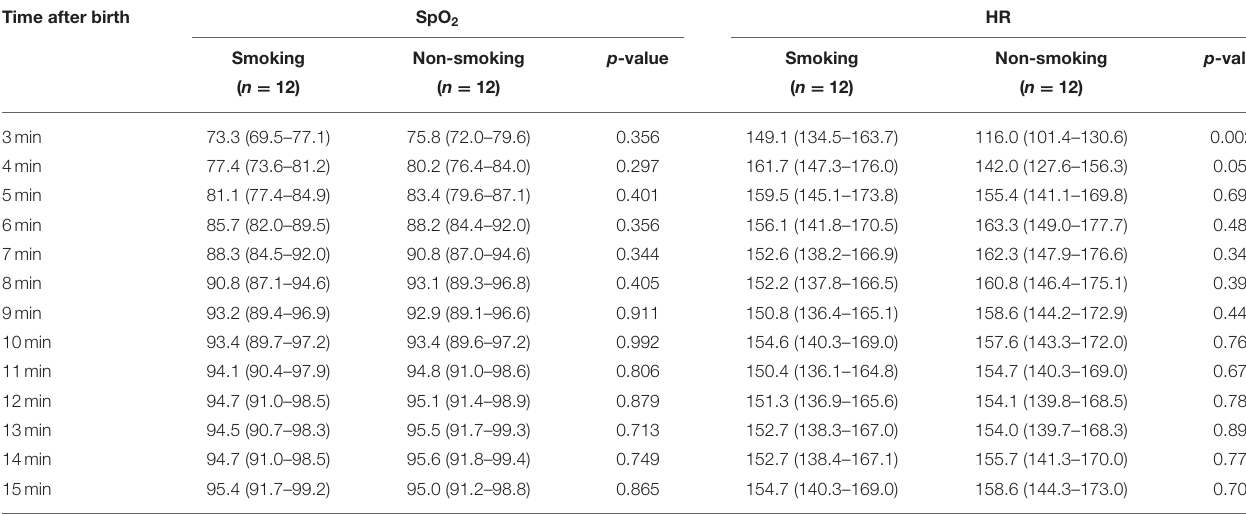
TABLE 3 | Arterial oxygen saturation (%) and heart rate (bpm) in term neonates from mothers who had smoked during pregnancy compared to term neonates from mothers who had not smoked during pregnancy (smoking group and non-smoking group). Time after birth SpO 2 HR p -value Smoking Non-smoking p-